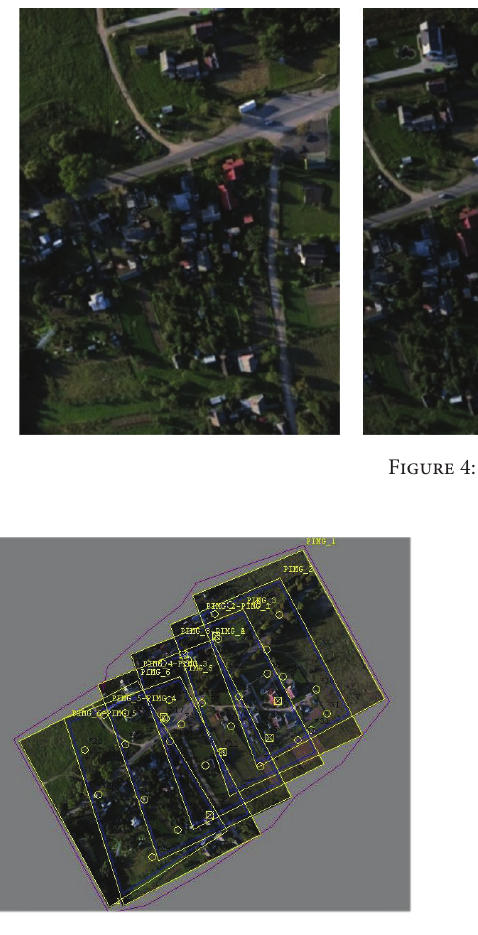
Figure 5: Geometric model of the area.